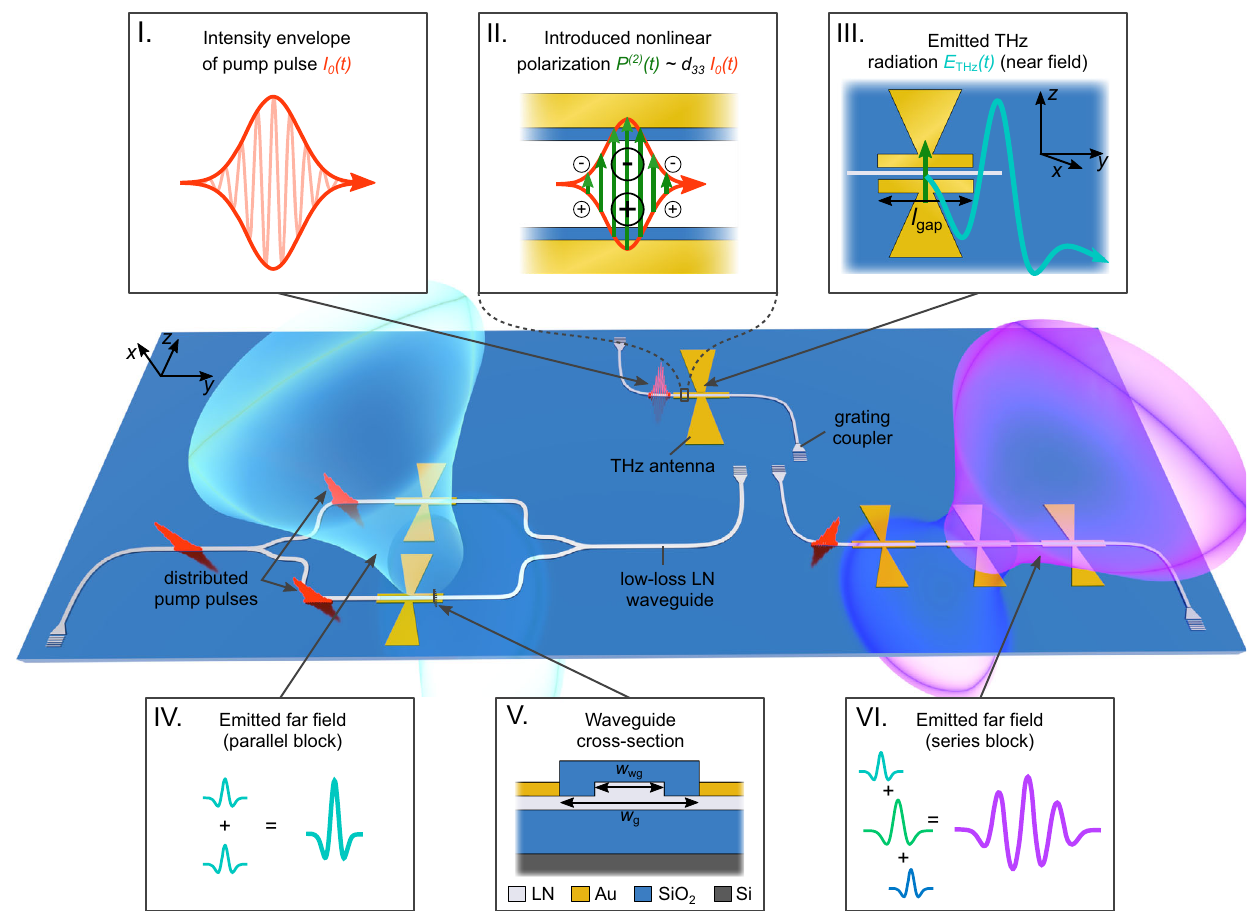
Fig. 1 | Chip-based terahertz (THz) waveform synthesis from thin- fi lm lithium niobate (TFLN) circuits. A single THz emitter consists of an etched TFLN wave- guide and a THz antenna (upper center chip design). Femtosecond pulses (shown in red) are coupled into the low-loss TFLN waveguides of width w wg =1.5 μ m and pass through the two electrodes of a THz bow-tie antenna (shown in yellow) separatedbyawidth w g (de fi nedininsetV).THzradiation(showninblue/purple)is generated through optical recti fi cation in the antenna gap region delimited by parallel gold bars of length l gap . The femtosecond pump pulse (inset I) generates a second-order polarization P (2) ( t ) that follows its envelope inside the χ (2) waveguide (inset II). The nonlinear polarization inside the gap drives the emission of a broadband THz fi eld E THz ( t ) into free space at the resonance frequency of the